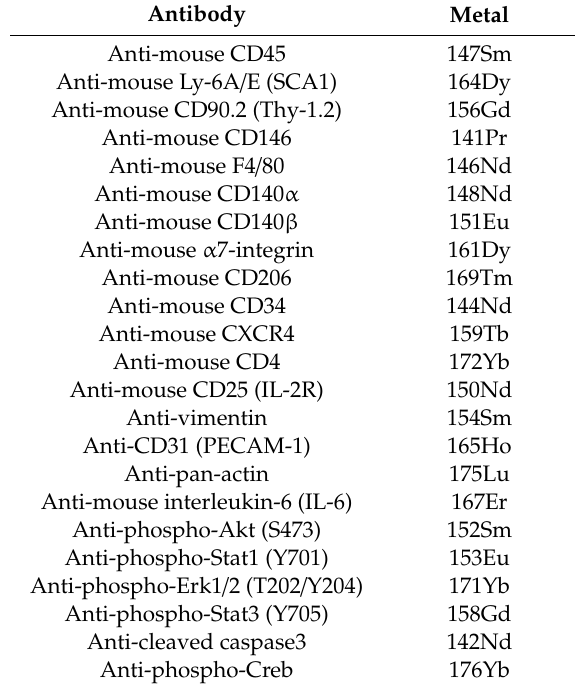
Table 1. List of the metal-tagged antibodies used in the mass cytometry experiments.